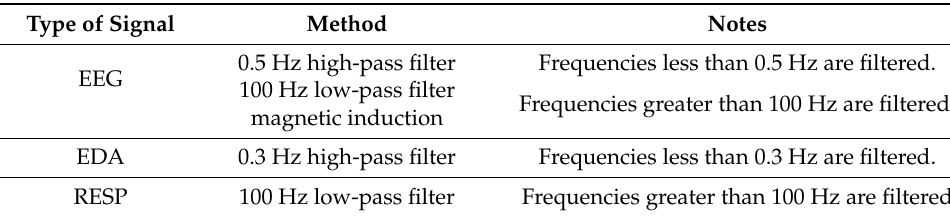
Table 2. The definitions of parameters for data